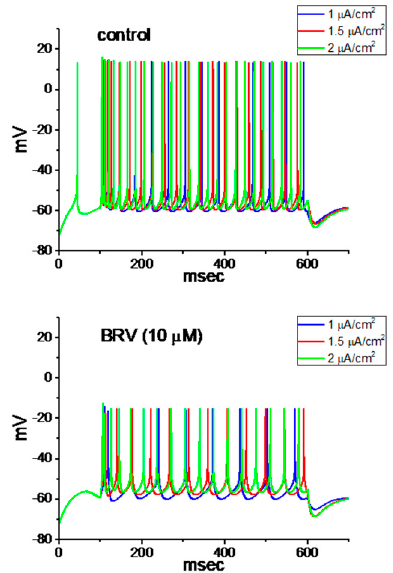
Figure 9. Simulated firing of action potentials (APs) generated from the modeled neuron to mimic the effects of BRV. AP traces in the upper and lower part of the figure indicate those theoretically simulated to mimic the control condition in which BRV was not present and the experimental condition in the presence of BRV (10 µM), respectively. The AP firing in each panel was evoked by a 500 ms current stimulus at a strength of 1, 1.5 and 2 µA/cm 2 . The values used for this numerical simulation are illustrated in Table 1.